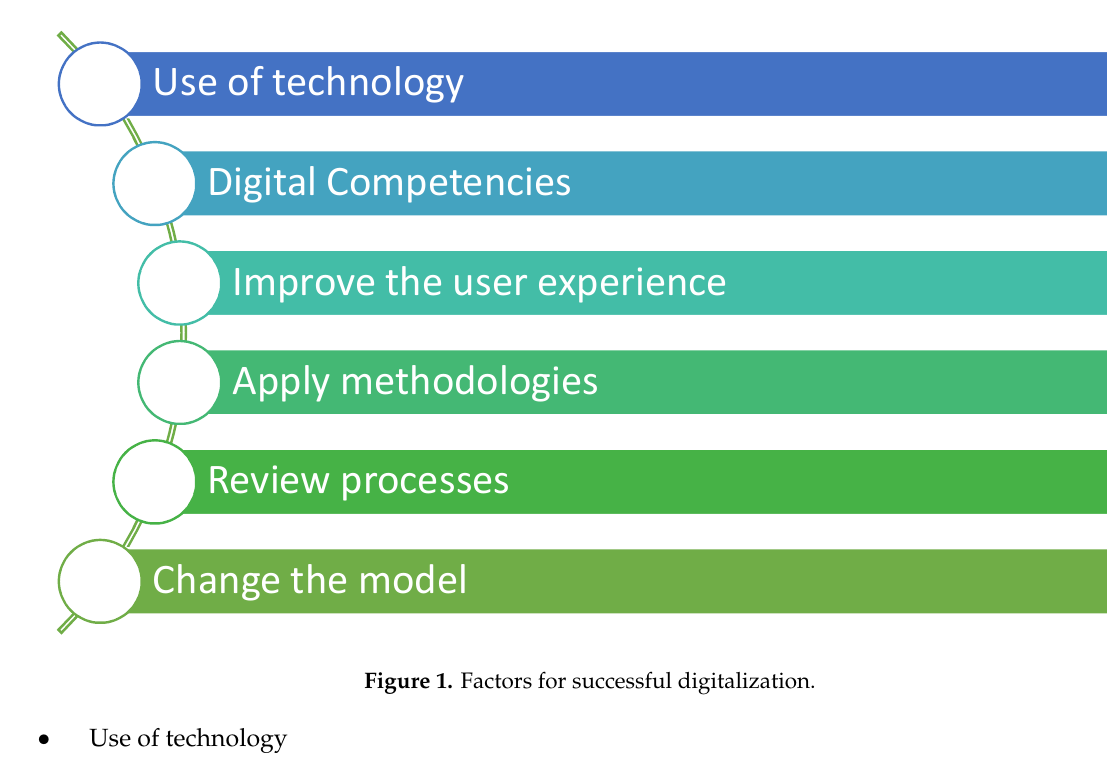
Figure 1. Factors for successful digitalization.